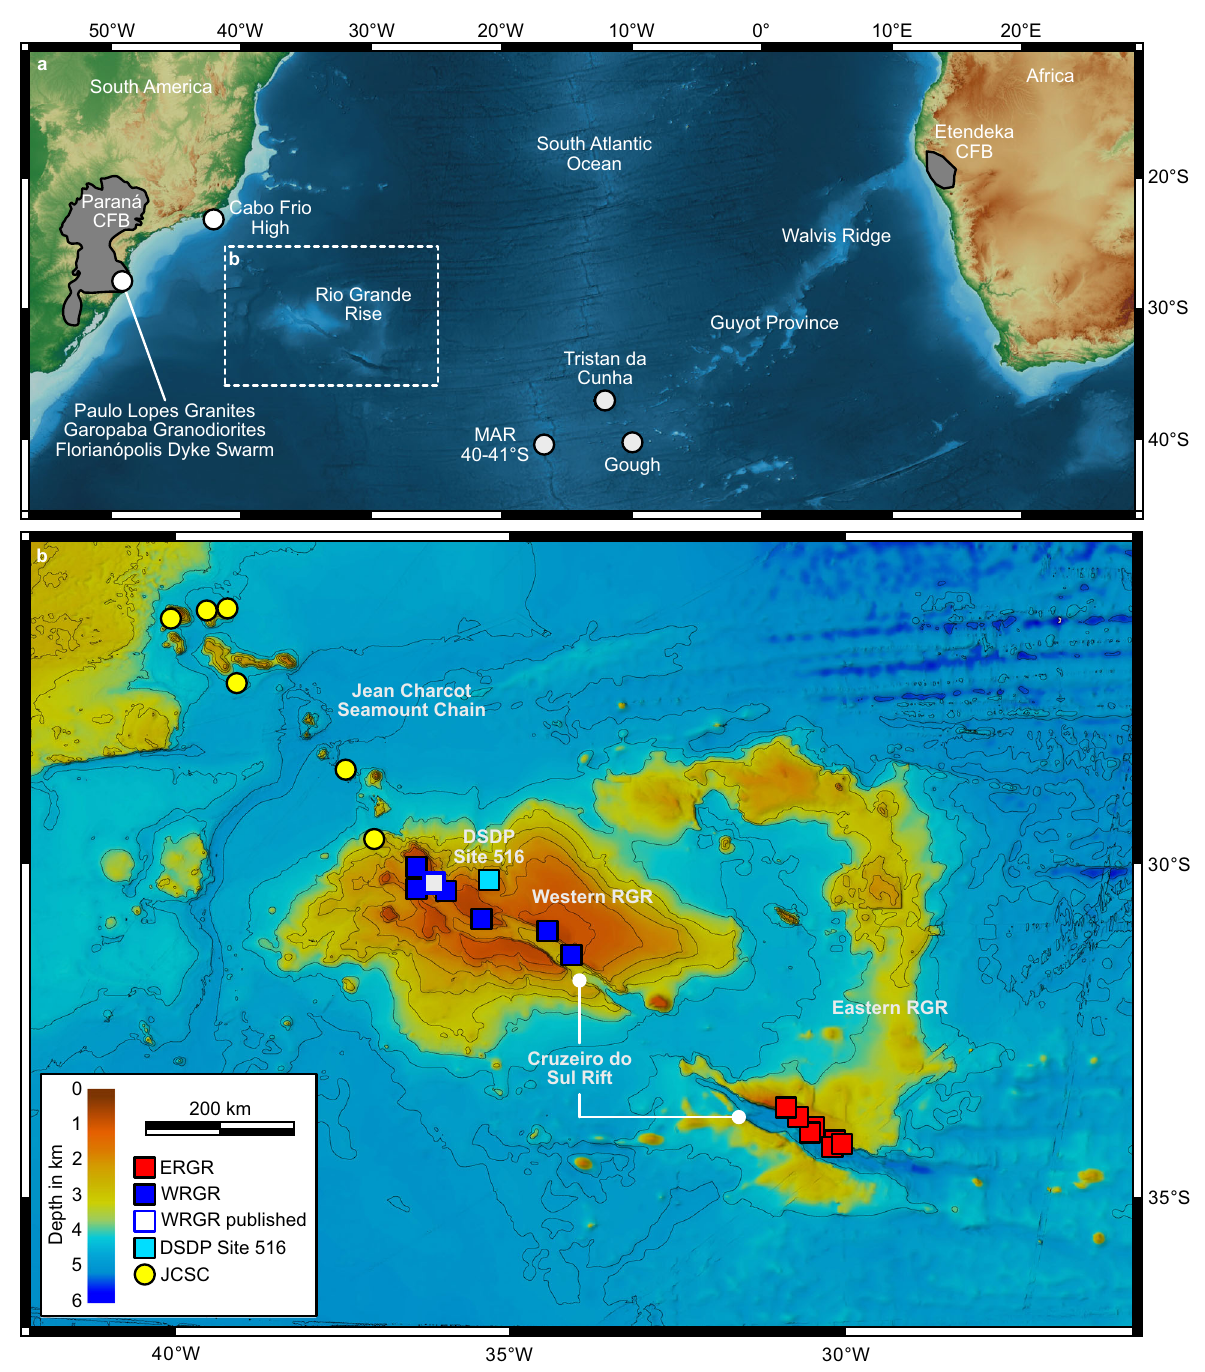
Fig. 1 Bathymetric map of the South Atlantic Ocean. a The map shows the locations of the Rio Grande Rise and Walvis Ridge. Grey areas on the South American and African continents are the Paraná and Etendeka Continental fl ood basalt provinces (CFBs), respectively. MAR stands for Mid-Atlantic Ridge. b Zoomed map section from a . Detailed map of the Rio Grande Rise showing the Eastern Rio Grande Rise (ERGR), Western Rio Grande Rise (WRGR) and the Jean Charcot Seamount Chain (JCSC). The blue framed white square marks the position of a dredge site from where alkaline samples with an age of ~46 Ma 16,18 were previously collected. White arrows mark the deep valley of the Cruzeiro do Sul Rift (CdSR). Contour line interval is 500 m. Digital elevation models are based on the GEBCO_2020 Grid